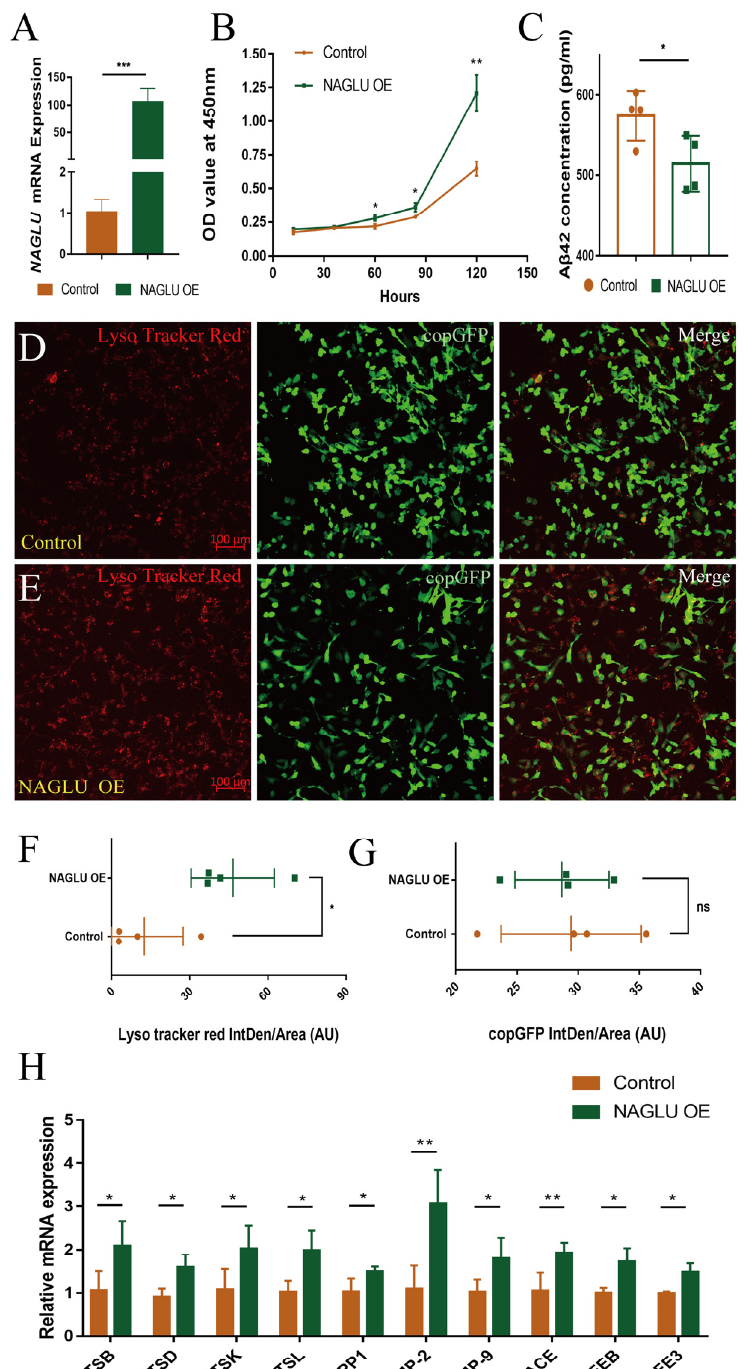
Figure 6. Effects of NAGLU overexpression in human U251-APP cells: ( A ) qRT-PCR validation for expression of NAGLU in U251-APP cells (*** p <0.001, t-test); ( B ) cell proliferation curve for NAGLU over-expressing cells detected by cell counting assay (* p <0.05, ** p <0.01, t-test); ( C ) detection of A β 42 concentration in cell supernatants by ELISA (* p <0.05,t-test); ( D , E ) immunofluorescence using Lyso Tracker Red in cultured cells; ( D ) U251-APP cells; ( E ) NAGLU overexpressing U251-APP cells; ( F ) the integrated density of Lyso Tracker Red/area are shown as bar plots ( n = 4, p = 0.0209, t-test); ( G ) the integrated density of copGFP/area are shown as bar plots ( n = 4, p = 0.8375, t-test). * p <0.05, ns represents non-significant; ( H ) relative mRNA levels of genes involved in A β degradation and lysosomal pathway (* p <0.05, ** p <0.01, t-test). (OE represents overexpression.)